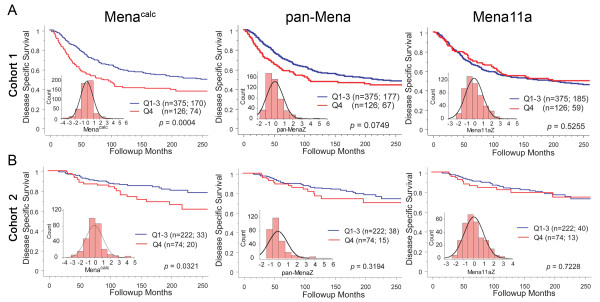
Kaplan-Meier analysis for Menacalc, pan-Mena and Mena11a in two primary breast cancer cohorts. Each cohort was divided into quartiles and disease-specific survival of the highest quartile of expression was compared to the remaining patient population. Inset is the histogram distribution of Menacalc or Z scores for each antibody. The number of patients in each group is shown followed by the number of patient deaths due to disease. Log-rank P-values are shown for 20-year follow-up. Only Menacalc scores are statistically significant in each cohort (P = 0.0004 and 0.0321, respectively).